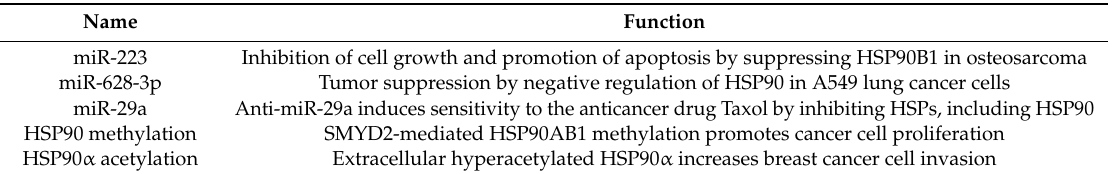
Table 3. Epigenetic regulations of HSP90